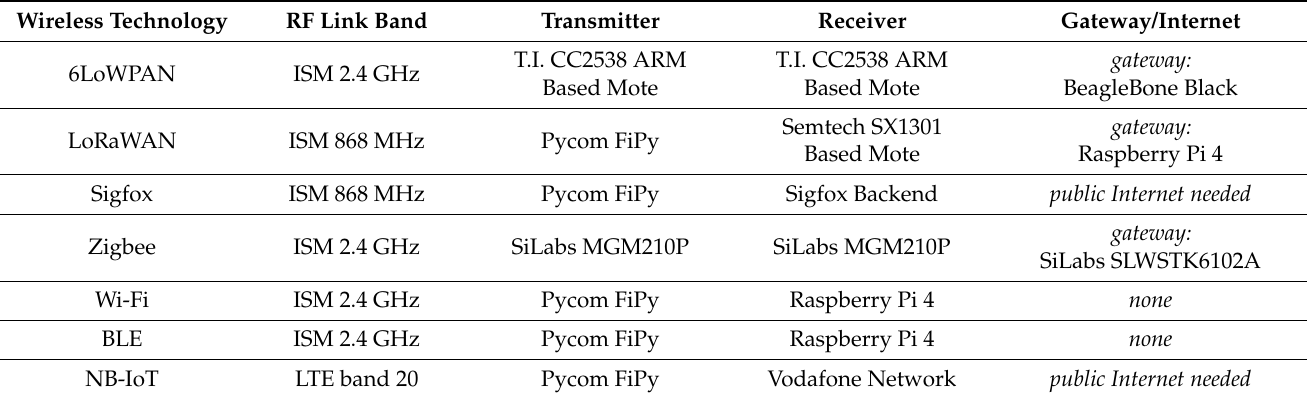
Table 1. Physical equipment, depending on the wireless